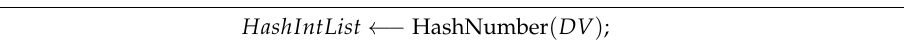
Algorithm 5: Hashing Algorithm